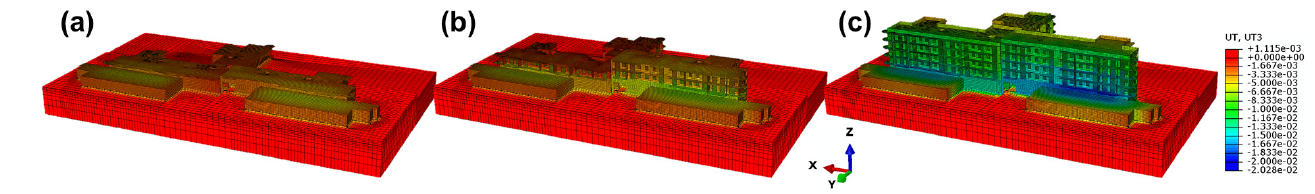
Figure 15. Vertical displacements in selected subsequent calculation steps [m]: ( a ) construction of the underground floor, ( b ) stage of construction at measurement 1, ( c ) stage after finishing the construction.